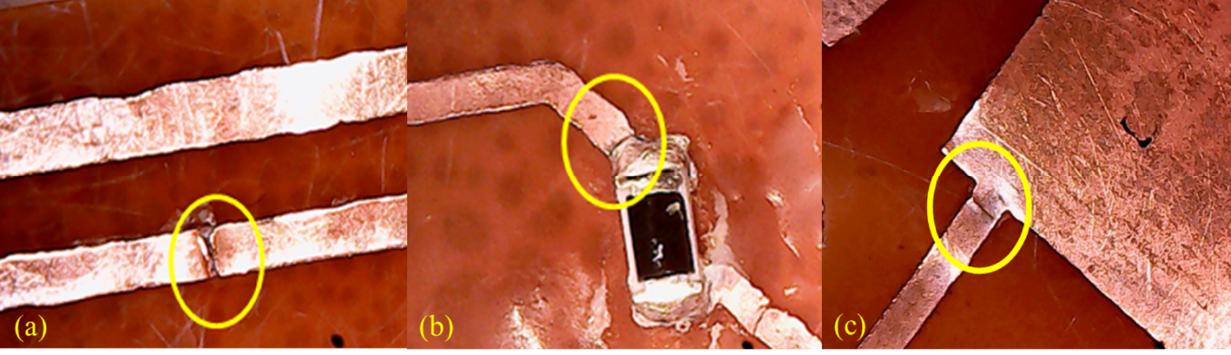
Figure 11. Damage analyses of washed PCBs with an optical microscope: ( a ) cracks in the track lines; ( b ) cracks at SMD pasting point; ( c ) cracks at the joint position of track lines and measuring pad.